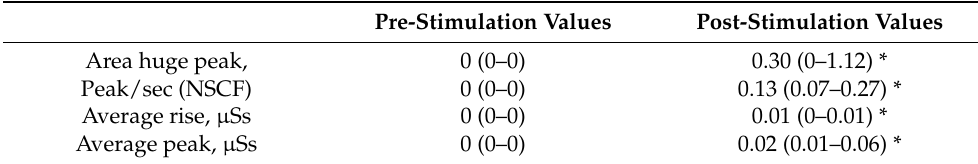
Table 3. Algesimeter values pre- and post-stimulation in the 15 patients with detectable NSCF. Data are presented as median (IQRs).